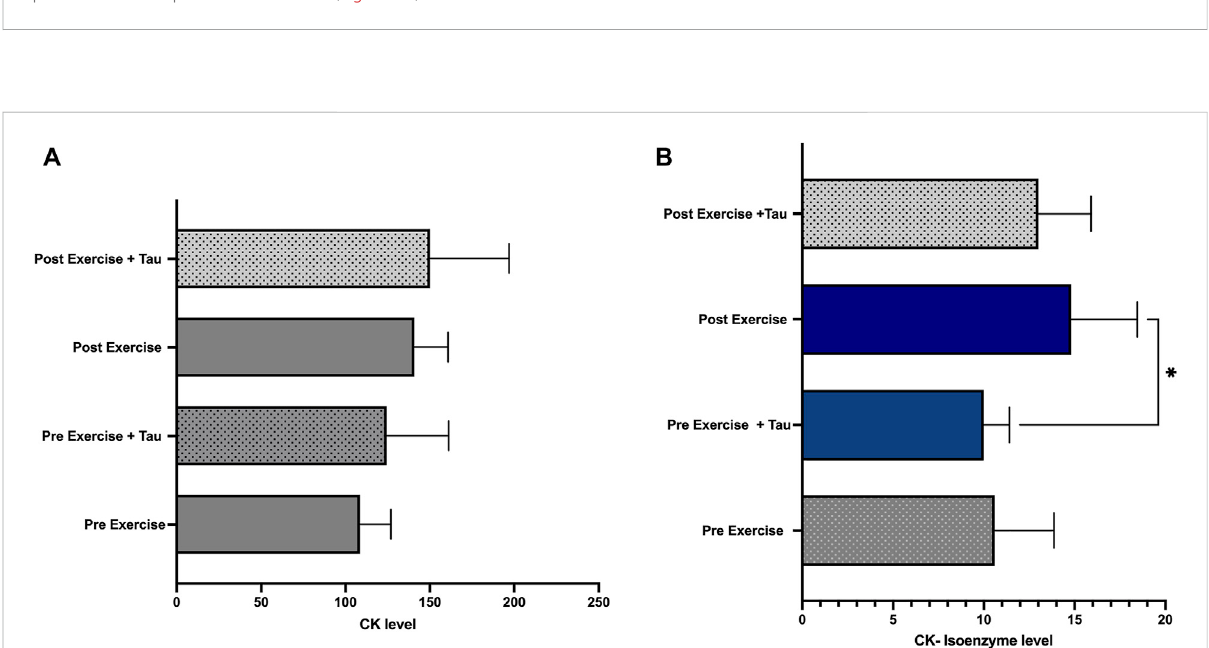
FIGURE 2 Effect of taurine (tau) on running exercise. AST level decreased in pre-exercise signi fi cantly when compared to post-exercise (** p < 0.05). AST level decreased in post-exercise + tau when compared to post-exercise (* p < 0.05) (Figure 2A). No changes were obtained in the LDH level of both postexercise and post-exercise + tau (Figure